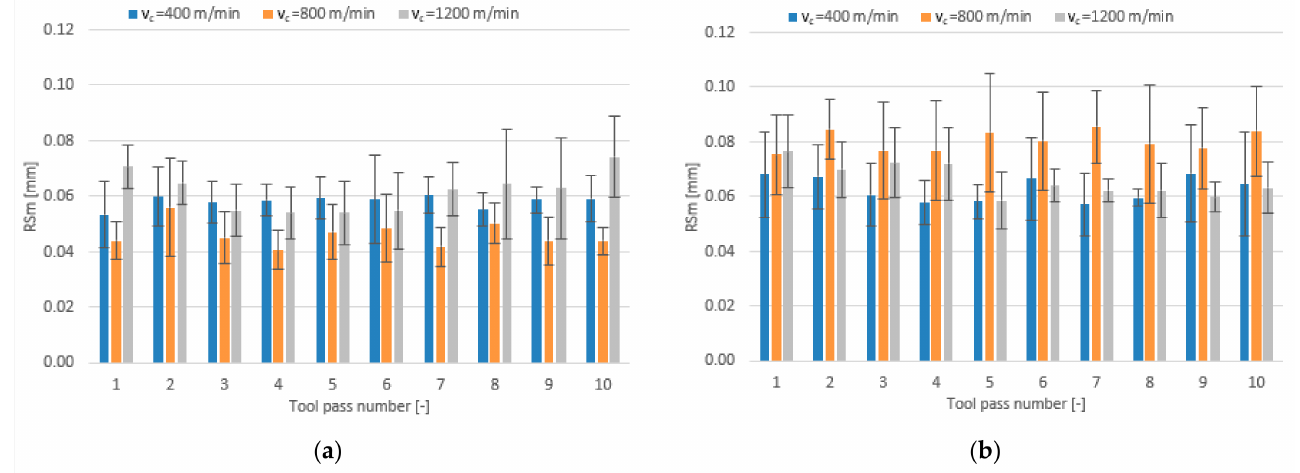
Figure 11. Cutting speed v c versus surface roughness parameter RSm in the milling process performed using a tool coated with: ( a ) TiB 2 and ( b ) TiAlN; (f z = 5 µ m/tooth; a p = 80 µ